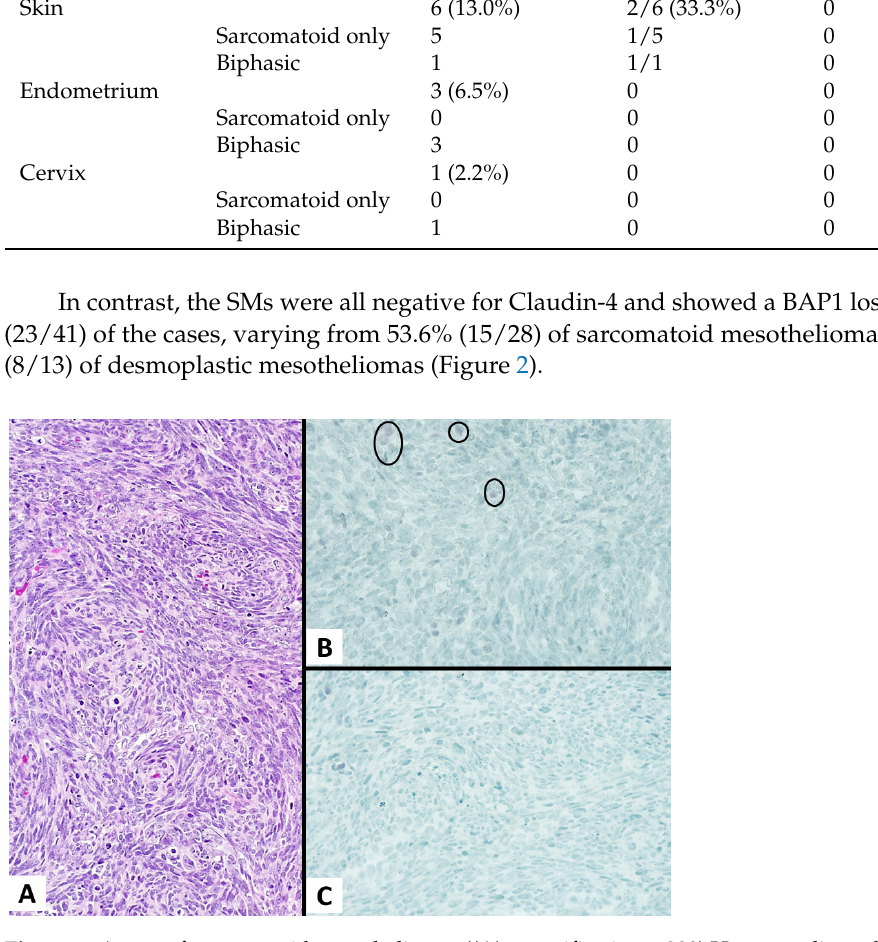
Figure 2. A case of sarcomatoid mesothelioma. (( A ) magnification ×200) Hematoxylin and eosin stain shows a sarcomatoid mesothelioma consisting of a highly malignant spindle cell growth; (( B ) magnification ×200) the tumor shows diffuse BAP1 loss (with some positive nuclei of lymphocytes into the circles as internal control) and (( C ) magnification ×200) negativity for Claudin 4. As expected, all the cases with normal mesothelium (14 cases) and reactive mesothelial proliferation (35 cases) were immunoreactive for BAP1 (no loss) and negative for Claudin-4. The detailed information on the Claudin-4 expression and the BAP1 loss is shown in Table 2. Table 2. Distribution of Claudin-4 and BAP1 immunostaining in the entire series. N.